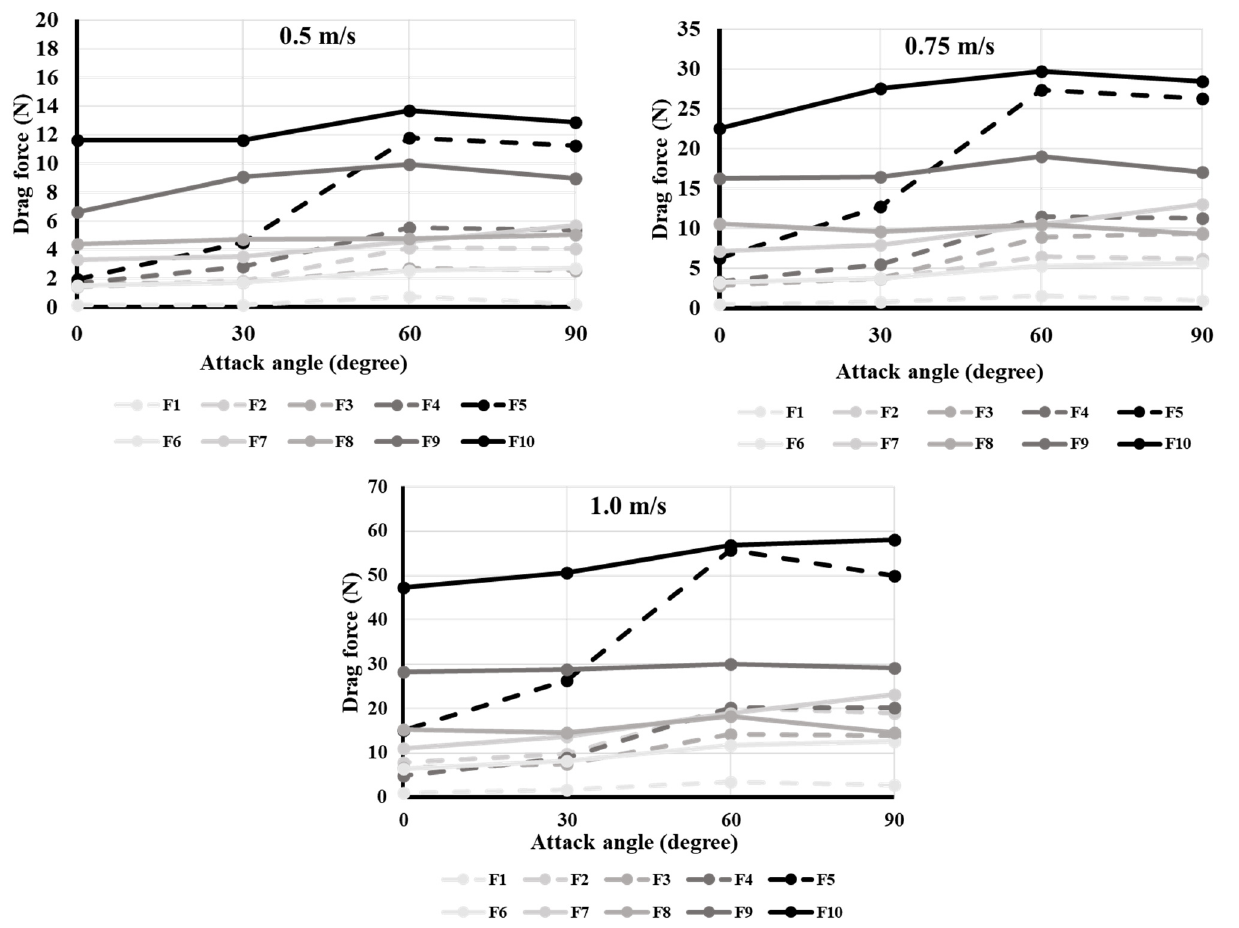
Figure 3. The drag forces of different floats and attack angles. (Straight line: ellipsoid-shaped, dotted line: sphere-shaped).